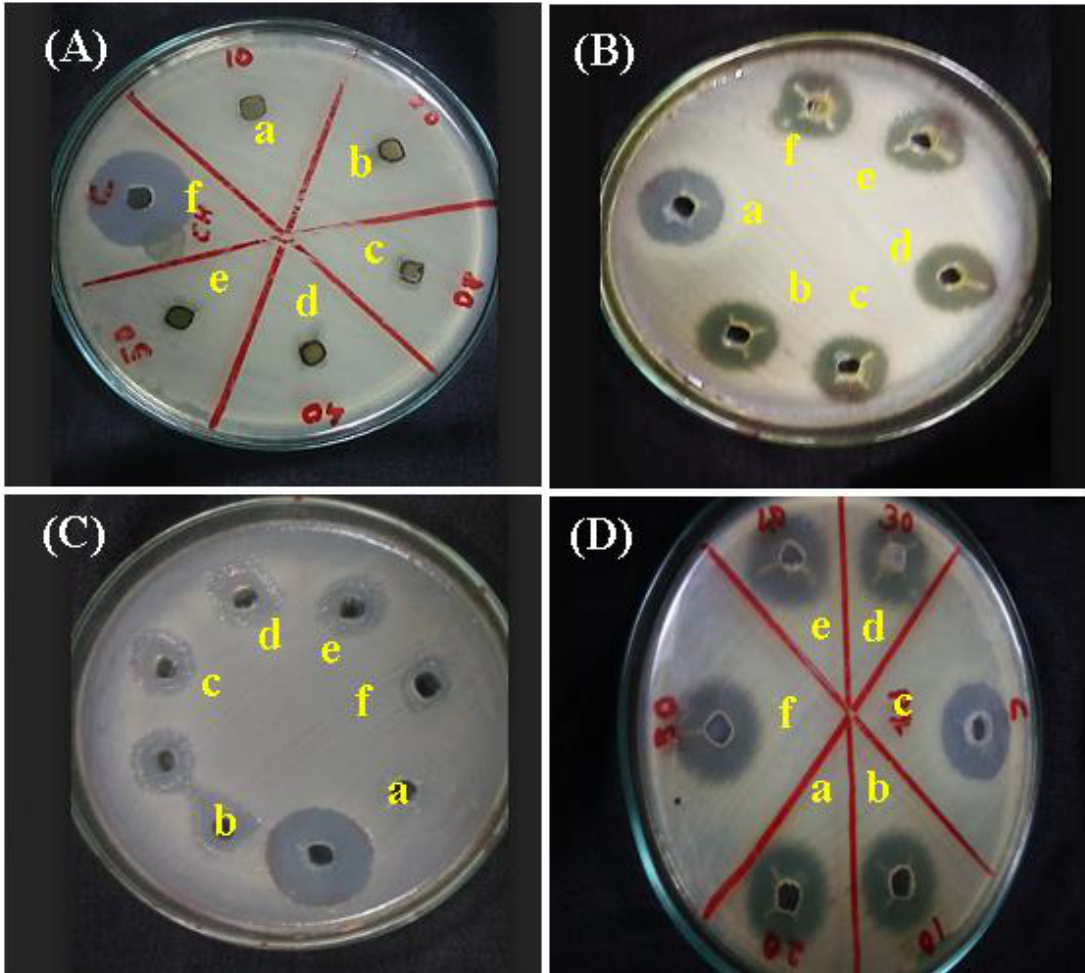
Figure 10. Agar Well diffusion antibiotic sensitivity assay with (a) hydrogel; (b) hydrogel + GO; (c) hydrogel + rGO; (d) aloe vera gel; (e) aloe vera gel + GO; (f) aloe vera gel + rGO against ( A ) Pseudomonas aeruginosa , ( B ) Bacillus subtilis , ( C ) Staphylococcus aureus and ( D ) E. coli.